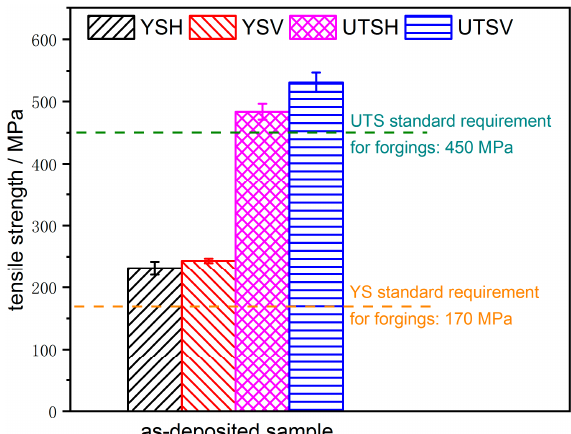
Figure 13. Average values of yield and ultimate tensile strength in the horizontal and vertical directions.